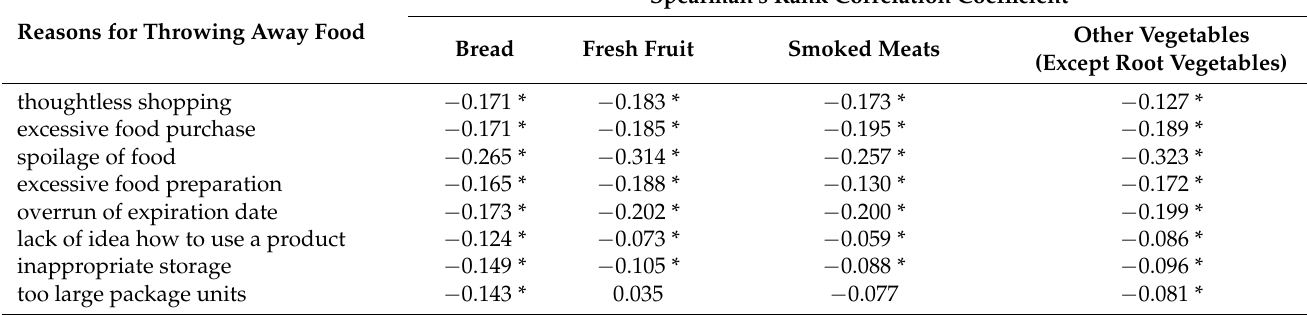
Table 6. Calculated coefficients of the Spearman rank (r) between the frequency of throwing away food and the reasons for doing it.